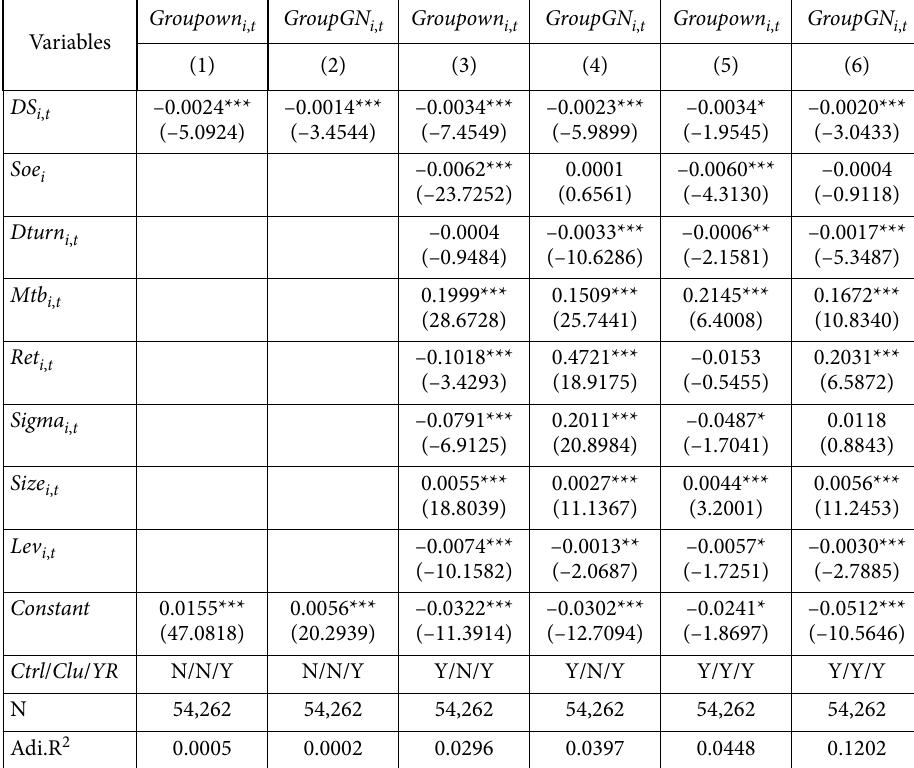
Table 6. Corporate strategy deviation and institutional investor